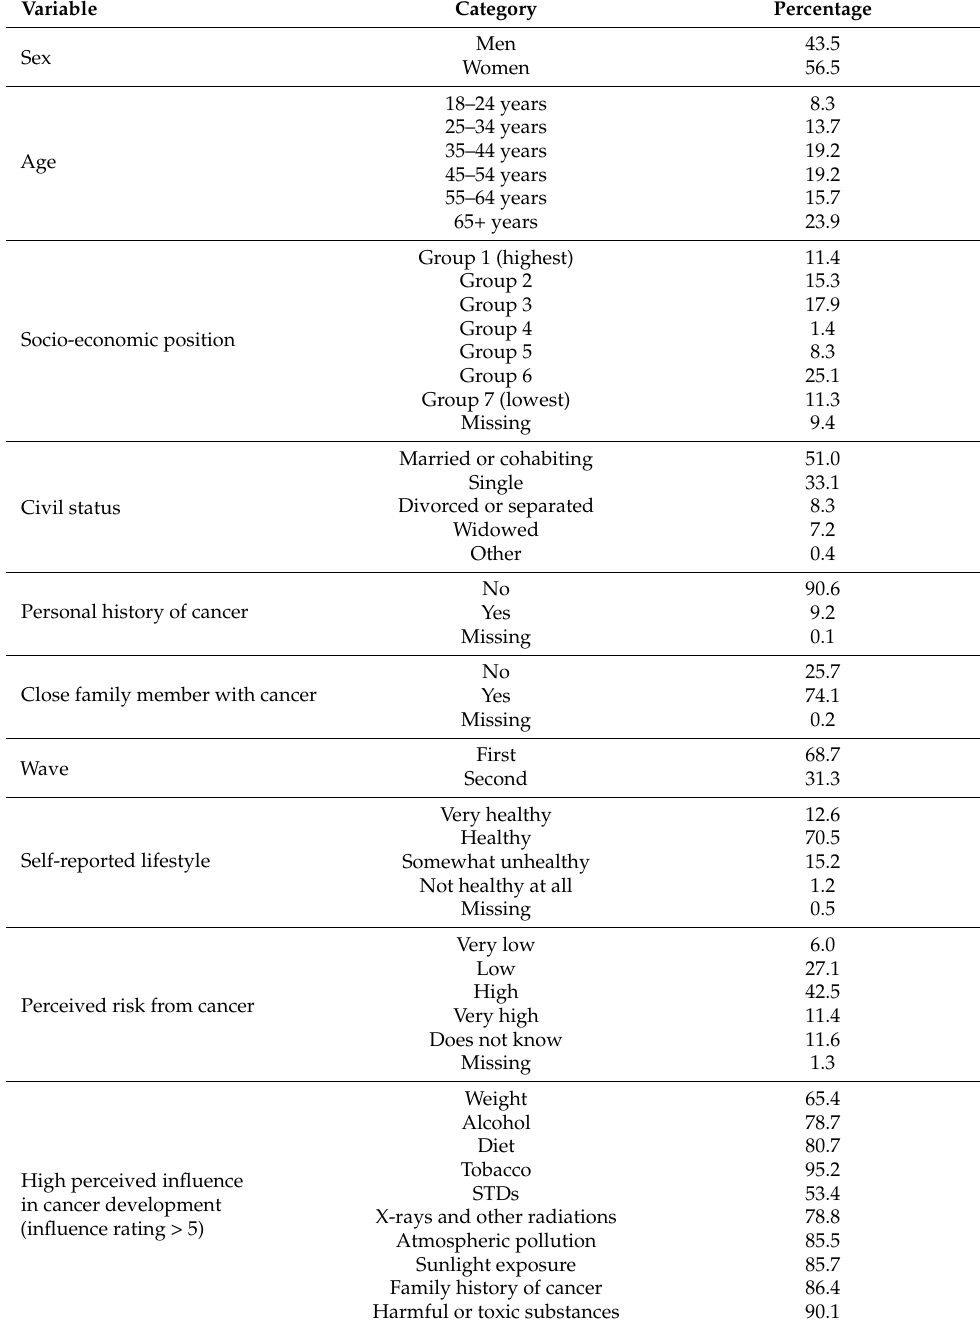
Table 1. Demographic characteristics and descriptive statistics of the sample (n =